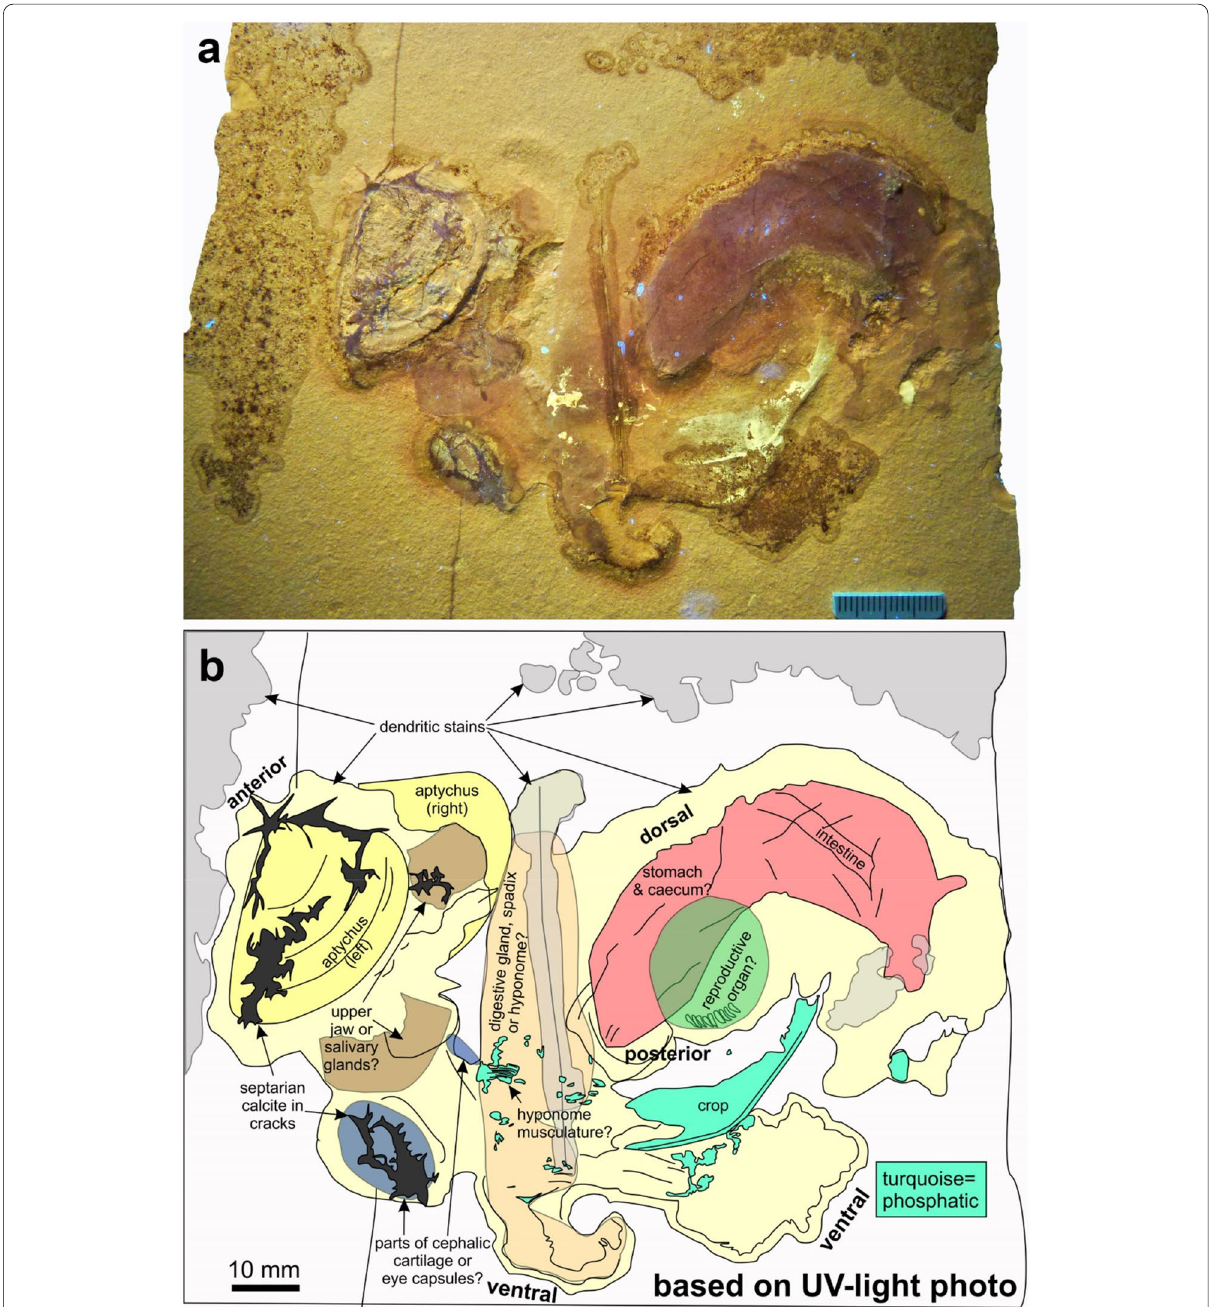
Fig. 2 Soft parts of Subplanites sp. with a Strigogranulaptychus sp. from the early Tithonian of Wintershof near Eichstätt (Germany); SMNS 70610. a Photo taken under UV‑light. b Line drawing of the structures visible in the UV‑photo ( a ) with possible